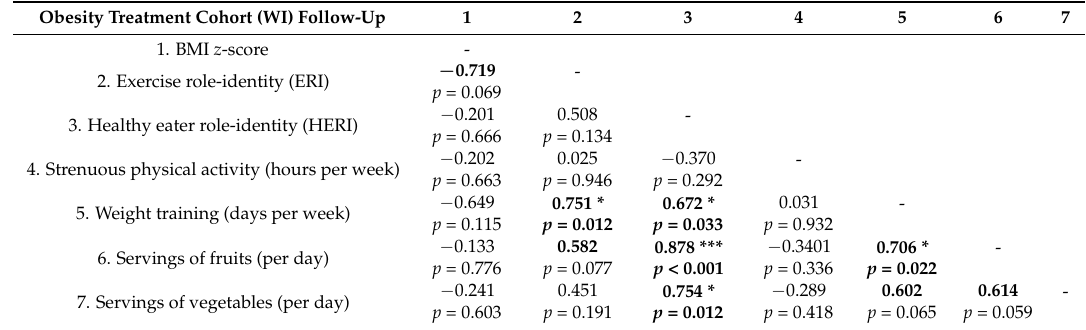
Table 7. Pearson coefficient and p value of select variables demonstrating follow-up correlations between ERI and weight training (positive; strong), HERI and weight training (positive; moderate), HERI and fruit (positive; strong), and vegetable consumption (positive; strong) in the obesity treatment